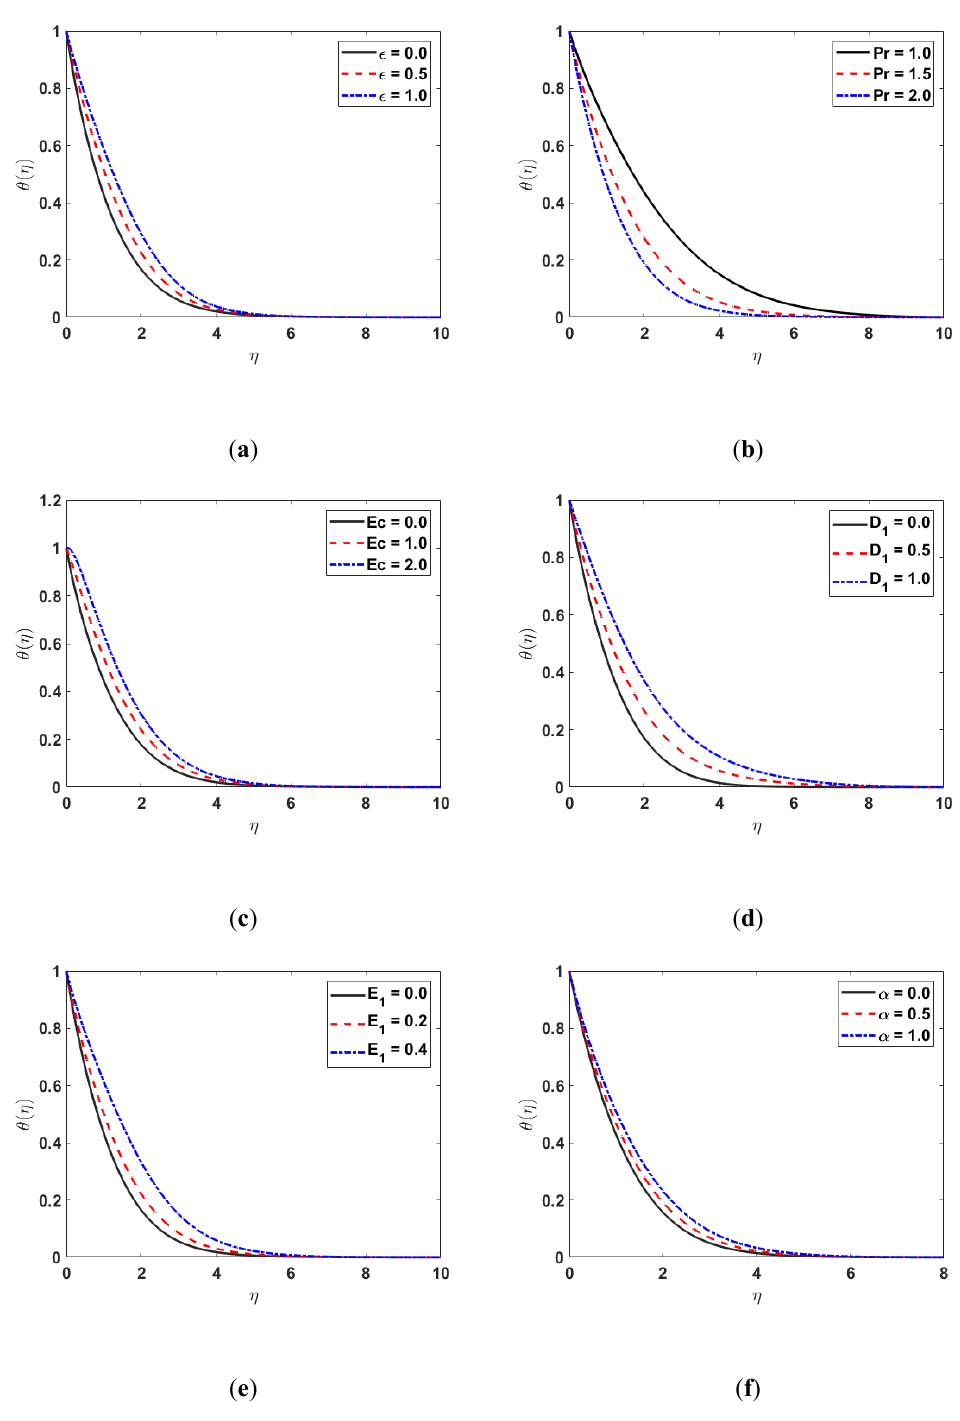
Figure 3. ( a ) 𝜃(cid:4666)𝜂(cid:4667) along 𝜖 ; ( b ) 𝜃(cid:4666)𝜂(cid:4667) along 𝑃𝑟 ; ( c ) 𝜃(cid:4666)𝜂(cid:4667) along 𝐸𝑐 ; ( d ) 𝜃(cid:4666)𝜂(cid:4667) along 𝐷 (cid:2869) ; ( e ) Figure 3. ( a ) θ ( η ) along (cid:101) ; ( b ) θ ( η ) along Pr ; ( c ) θ ( η ) along Ec ; ( d ) θ ( η ) along D 1 ; ( e ) θ ( η ) along E 1 ; 𝜃(cid:4666)𝜂(cid:4667) along 𝐸 (cid:2869) ; ( f ) 𝜃(cid:4666)𝜂(cid:4667) along 𝛼 . ( f ) θ ( η ) along α